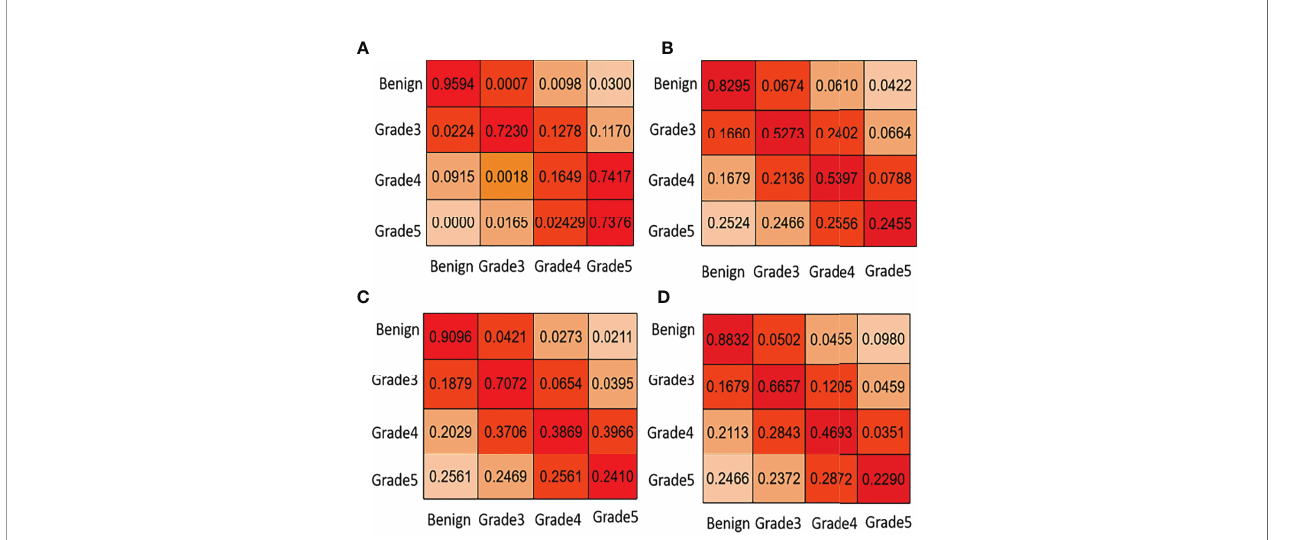
TABLE 2 | Results of different network models (boldface denotes best performance).